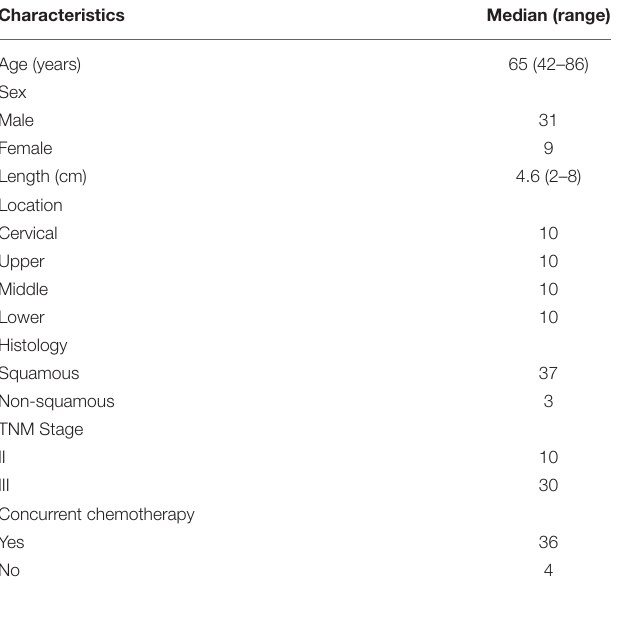
TABLE 1 | Patients’ characteristics.